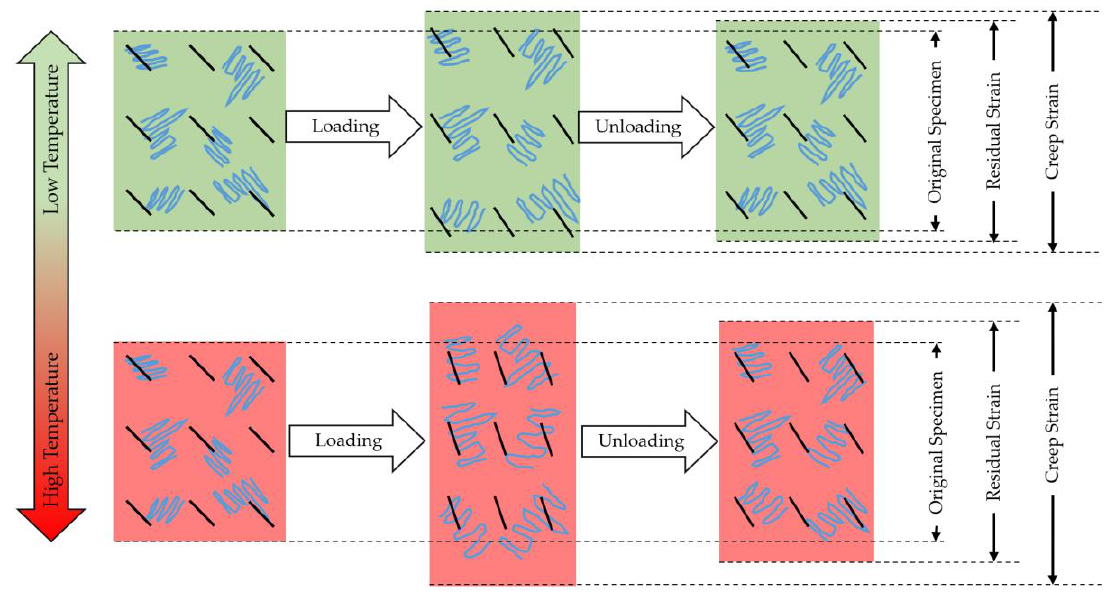
Figure 7. Possible mechanism in creep and recovery (effect of load and temperature on Onyx).